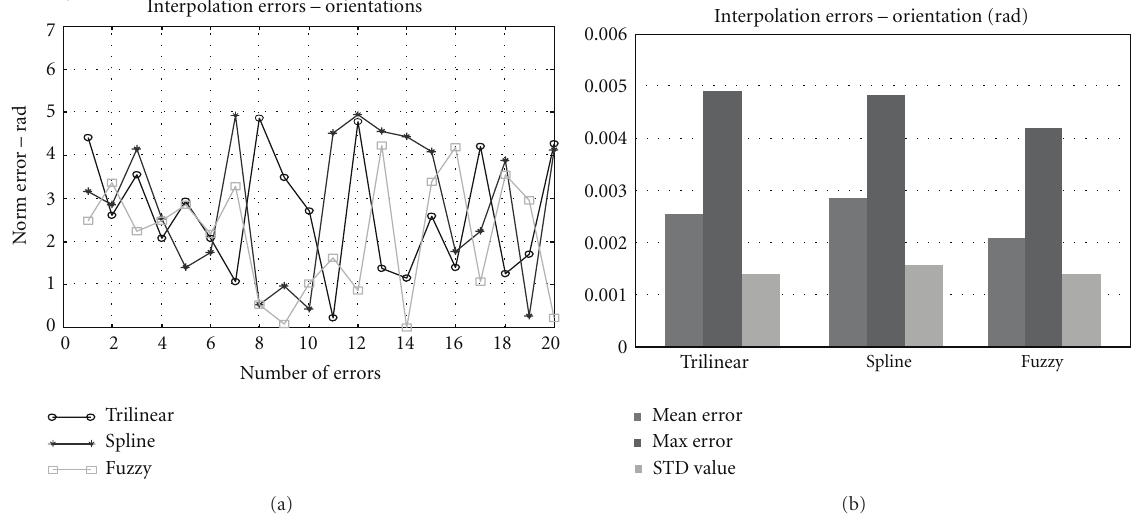
Figure 7: Simulated interpolation results—orientation